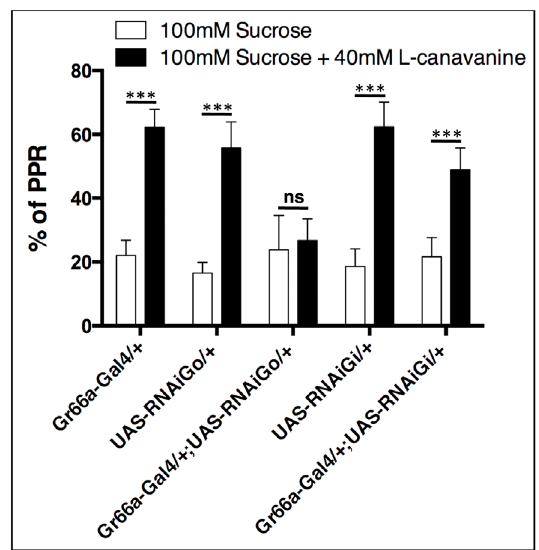
Figure 3. RNAi knockdown of G a o47A in bitter-sensitive taste neurons impairs L-canavanine-induced premature proboscis retraction. L-canavanine-induced premature proboscis retraction (PPR) was analyzed with 100 mM sucrose solution (white bars) and a solution containing 100 mM sucrose + 40 mM L-canavanine (black bars). For all genotypes, the percentage of PPR is very low when tarsi are stimulated with the sucrose solution. Gr66a-Gal4/ + , UAS-RNAiG a o47A/ + (UAS-RNAiGo/ + ) and UAS-RNAiG a i65A/ + (UAS-RNAiGi/ + ) control flies as well as Gr66a-Gal4/ + ;UAS-RNAiG a i65A/ + (Gr66a-Gal4/ + ;UAS-RNAiGi/ + ) flies prematurely retract their proboscis when tarsi are in contact with a L-canavanine containing sucrose solution. On the contrary, the percentage of Gr66a-Gal4/ + ;UAS-RNAiG a o47A/ + (Gr66a-Gal4/ + ;UAS- RNAiGo/ + ) flies that prematurely retracted their proboscis is very low, indicating that these flies maintained their proboscis extended due to L-canavanine detection defects. Error bars indicate SEM. Asterisks indicate significant differences by Unpaired Student’s t test (ns: not significant, *** p , 0.001).